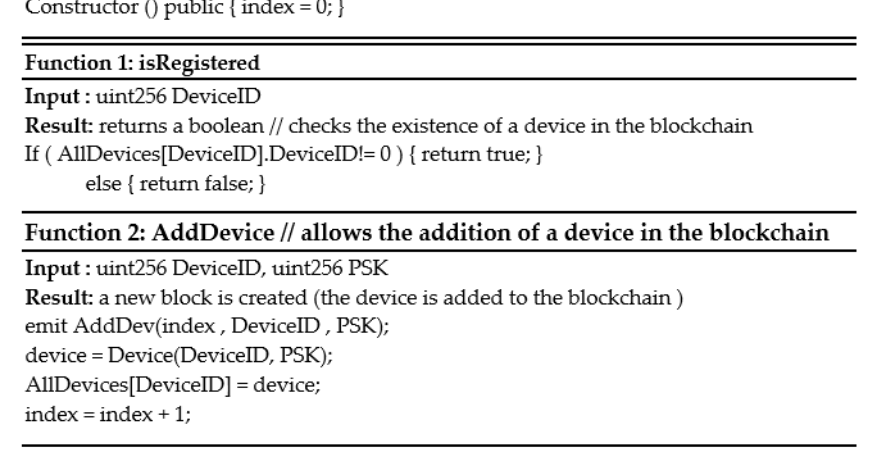
Figure 6. Authentication scheme smart contract.